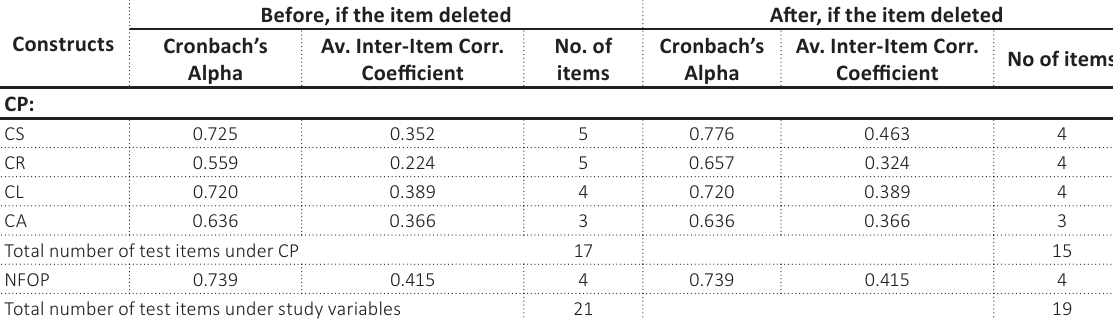
Table 2. Reliability measures